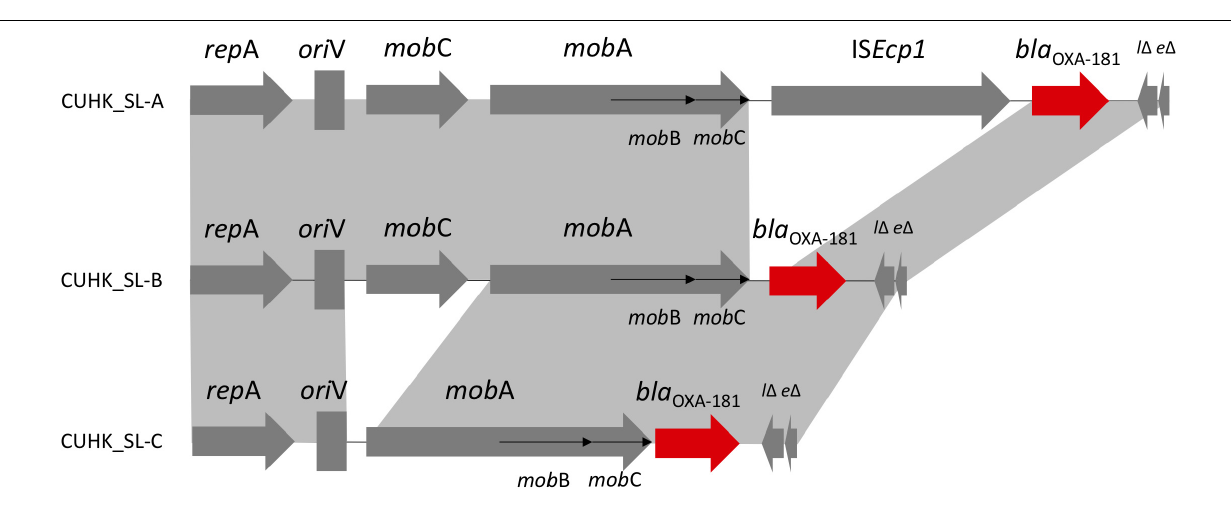
FIGURE 2 | ColE-type plasmids in Sri Lanka. ∗ CUHK_SL-B had IS Ecp1 deletion; CUHK_SL-C had IS Ecp1 and mob C